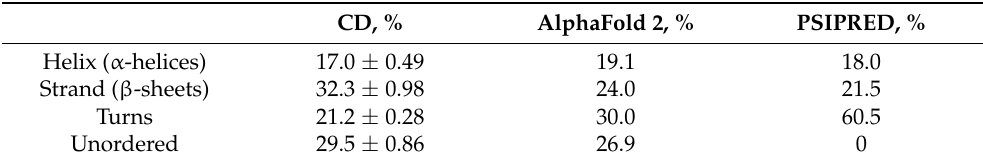
Table 1. The percentage of the secondary structure elements of the Svx protein of Pectobacterium atrosepticum calculated based on the circular dichroism spectroscopy data, AlphaFold 2 modeling and PSIPRED.